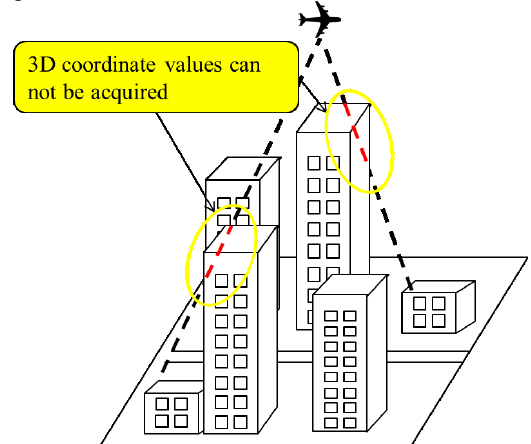
Figure 18. Hidden areas in centric camera projection